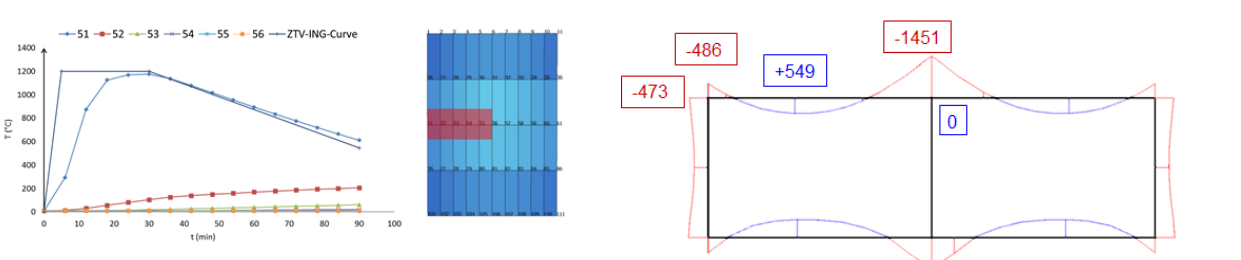
Figure 4. Temperature curves for an 80-cm-thick element at different nodes [11]. Figure 5. Bending moment diagram for t = 0 [4].